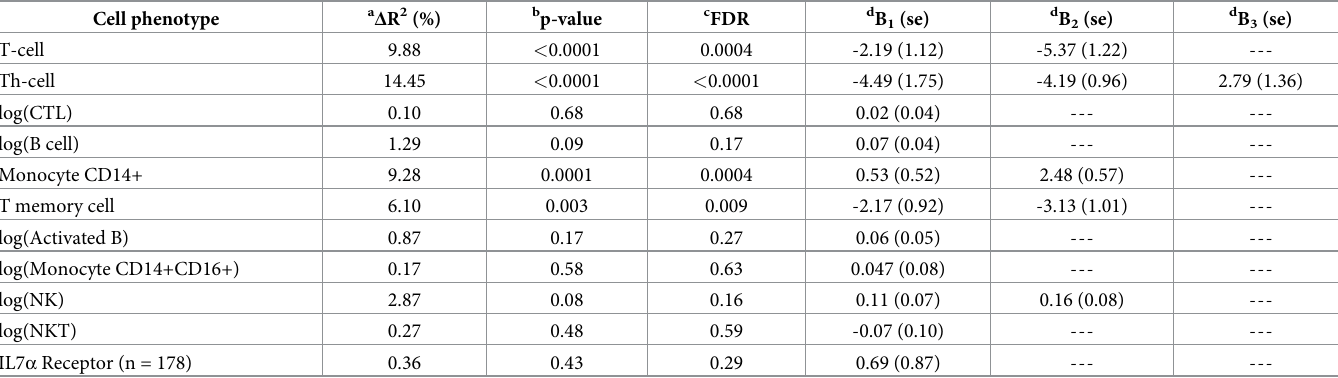
Table 3. Association between PAH-DNA adducts and immune cell phenotypes (n = 179). Cell phenotype